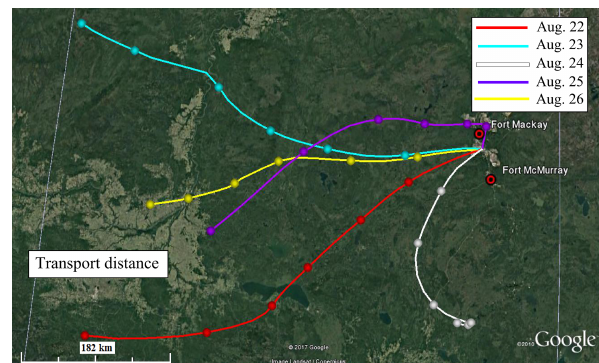
Figure 19. Backward air trajectories initiated from an altitude of 700m above sea level on 22 to 26 August 2013 at 13:00 local time (UTC − 6h). The round marks along each trajectory represent the distance travelled over time intervals of